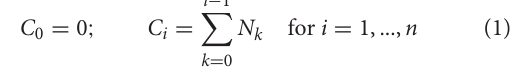
memory in a two-dimensional array, with the number of rows equal to the number of neurons and the number of columns equal to the maximum number of spikes that can be recorded before each extraction. Since the number of spikes per neuron is typically much smaller than the maximum, most entries of this array are zero. To compress the information, the spike times are periodically packed into contiguous positions of a one- dimensional buffer, which is copied from GPU memory to RAM along with a one-dimensional array indicating the positions at which the spikes for each neuron start. The packing